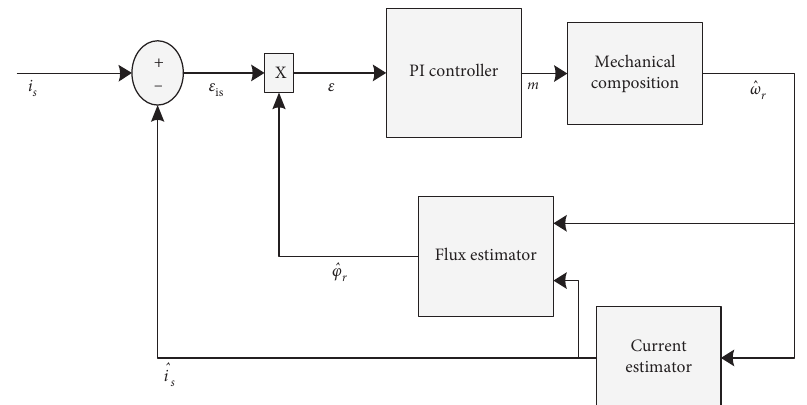
Figure 4: Closed loop stator current-based MRAS speed estimator with mechanical estimator can be analyzed as a system controlled by the PI controller parameter changes, on the basis of the esti- signal, which is the combination of the stator current and the mator transfer function. From the point of view of the rotor rotor flux used in the adaptation loop. To find the value of speed estimation, the stator current-based MRAS speed